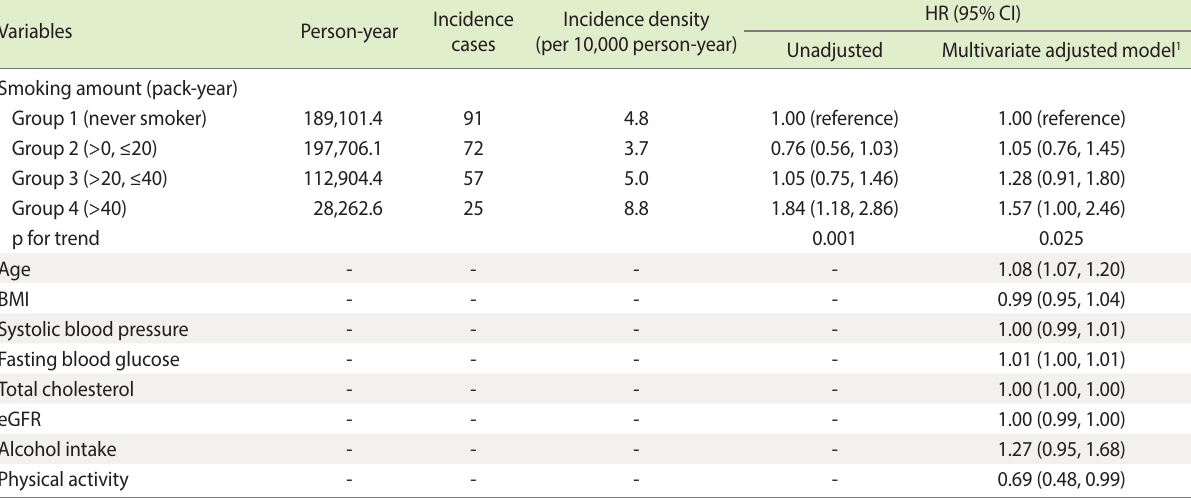
Table 2. HRs and 95% CIs for the incidence of pancreatic cancer according to 4 smoking amount groups Variables